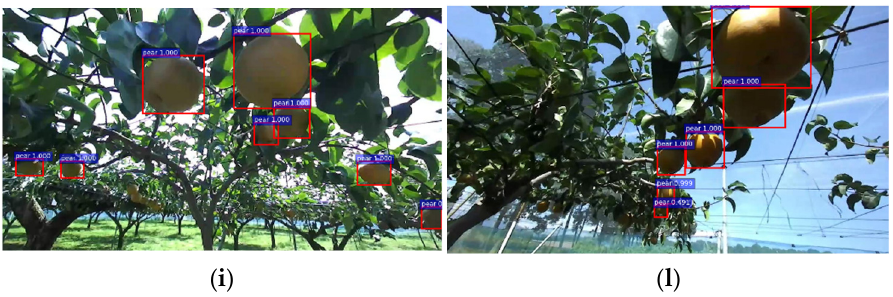
Figure 13. Results of Mask-RCNN in different situations. Recognition of ( a – c ): separated pears in low light; ( d – f ): aggregated pears in low light; ( g – i ): separated pears in strong light, and ( j – l ) aggregated pears in strong light. ( a , d , g , j ) Original image; ( b , e , h , k ) Testing image in Mask R-CNN; and ( c , f , i , l ) Testing image in Faster R-CNN.